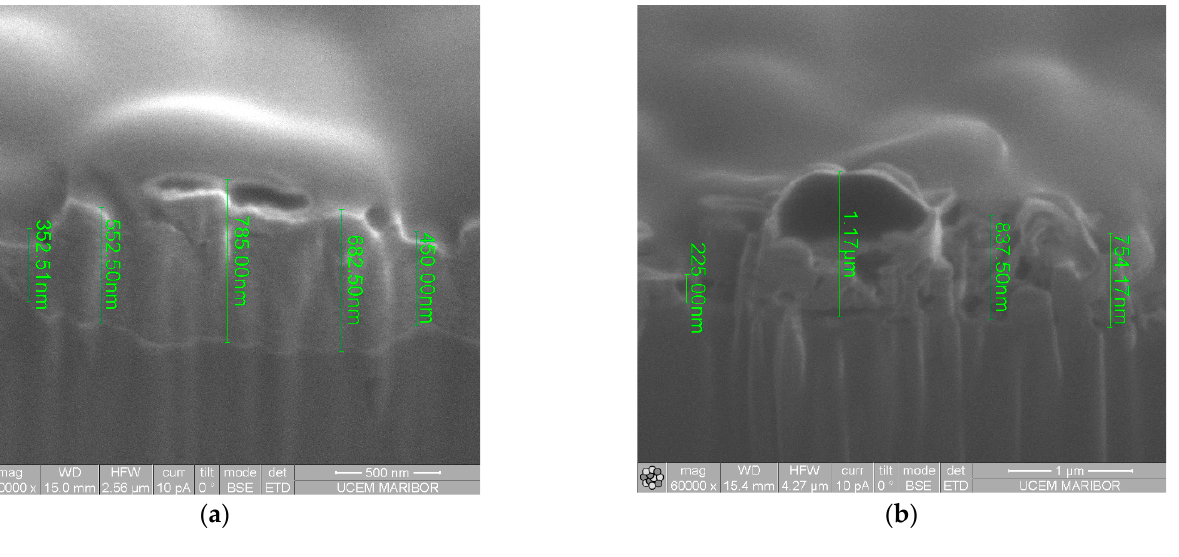
Figure 3. FIB measurement value of the corrosion layer in nm on the NiTi ‐ 1 sample 18 months in the sea (with 100,000 magnification) ( a ) and measurement value of the corrosion layer in nm on the NiTi ‐ 2 sample 18 months in the sea (with 60,000 magnification) ( b ).